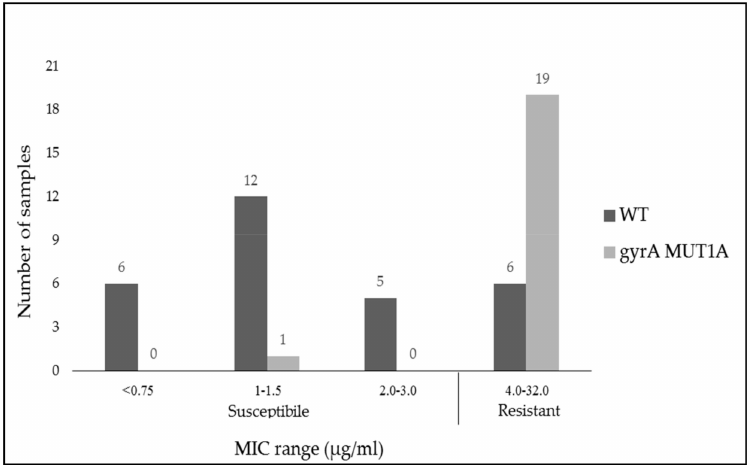
Figure 3. Sample distribution by MIC ranges and allele appearance for moxifloxacin antibiotic. * WT = Wilt type; MIC = Minimum inhibitory concentration.